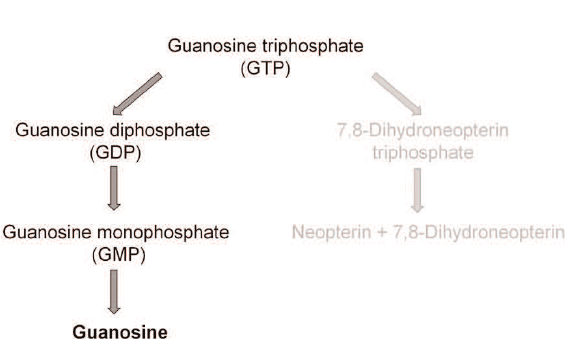
Figure 1. Schematic model of the sources of guano- sine and the neopterin derivatives. The purine nucleo- side guanosine is the product of stepwise dephospho- rylation of guanosine triphosphate (GTP) to guanosine diphosphate (GDP) and guanosine monophosphate (GMP) by ecto-nucleotidases. In parallel GTP may be enzymatically cleaved by GTP-cyclohydrolase I to 7,8-dihydroneopterin triphosphate, which is then fur- ther metabolized by dephosphorylation and oxidation to neopterin and